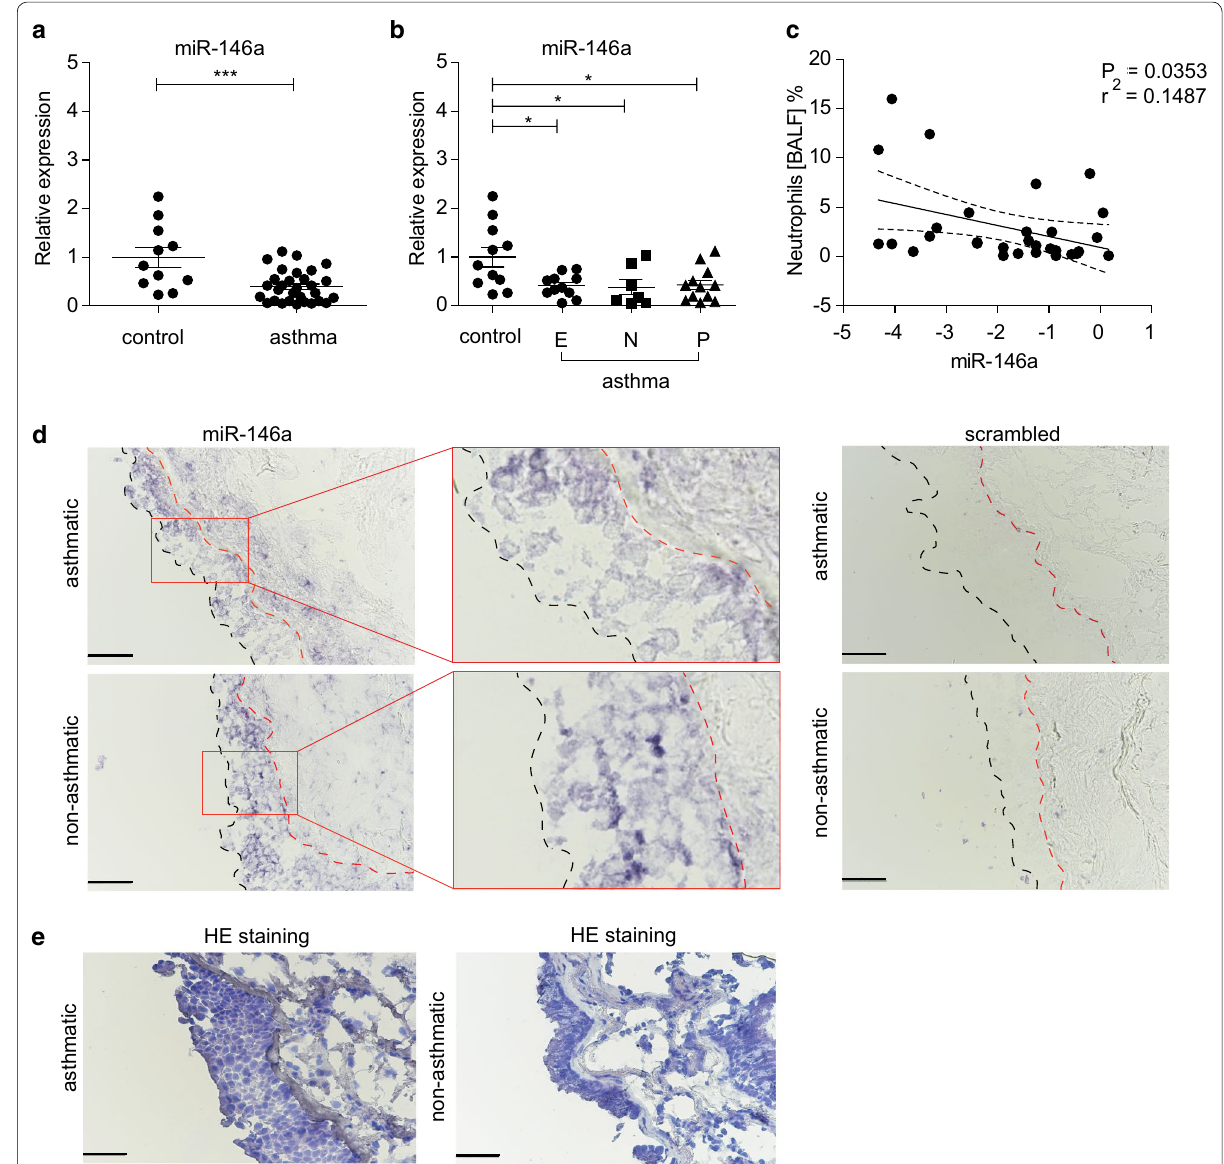
Fig. 1 The expression of miR-146a is downregulated in epithelial cells from airway biopsies of patients with asthma. a – c Relative expression of miR-146a in bronchial brushing specimens from patients measured by RT-qPCR. Data represent mean b Patients were categorized into inflammatory phenotypes based on BALF cell percentages: eosinophilic (E), > 2% of eosinophils and < 3% of neutrophils in BALF; neutrophilic (N), < 2% eosinophils and > 3% neutrophils in BALF; paucigranulocytic (P), < 2% of eosinophils and < 3% neutrophils in BALF). One-way ANOVA, *P < 0.05. c Linear regression analysis between miR-146a expression in asthmatic bronchial brushings (data presented on log2 scale) and neutrophil percentage among non-epithelial BALF cells. 95% confidence interval (CI) of the regression line is shown as dotted line. d, e 10 μm sections of frozen bronchial biopsy samples were subjected to in situ hybridization ( d ) or hematoxylin and eosin staining ( e ), bar 50 μm. d Blue color shows the expression of miR-146a. Black dashed line indicates the outer border of the epithelium layer in the specimen. = Red dashed line indicates the outer border of the basal lamina. One asthmatic and non-asthmatic sample representative of 3 and 2 subjects,